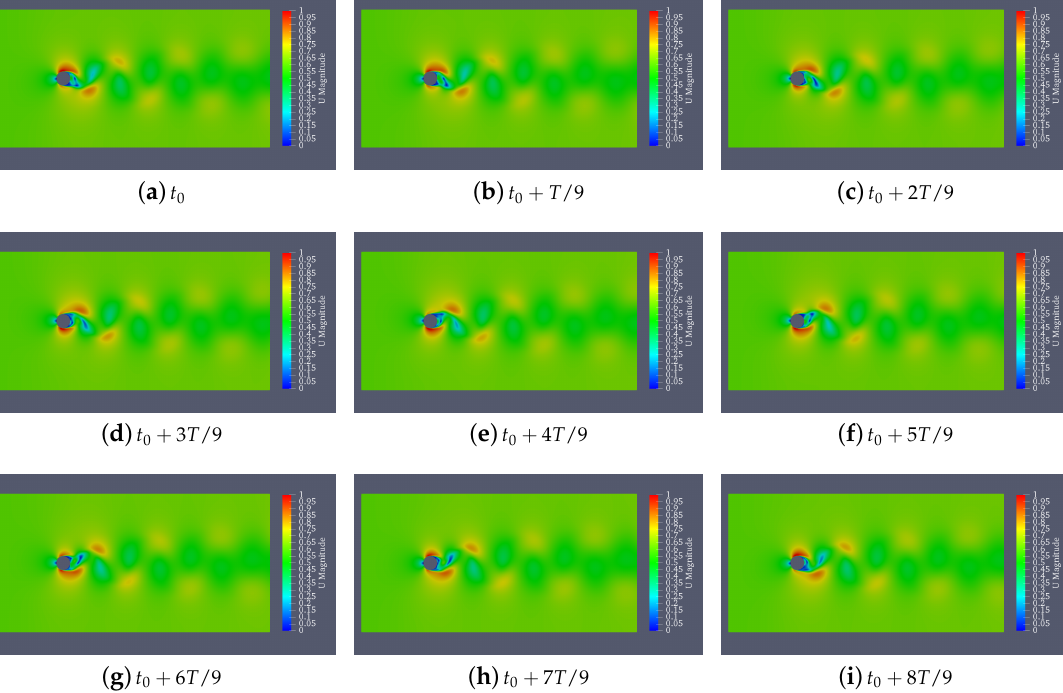
Figure 6. The wake morphology of the SSTKW model in one cycle ( T = 0.81 s), and subfigure ( a – i ) correspond to wake morphology at different times with interval ∆ t = 0.09 s. It is obvious that the vortex street is moving